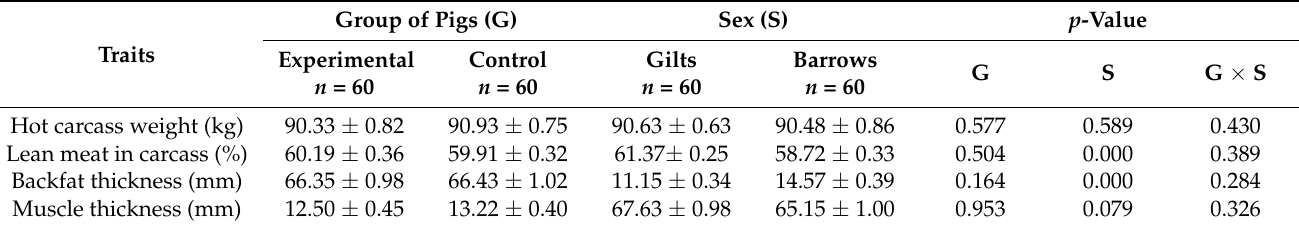
Table 4. Carcass quality and basic chemical composition of the LL